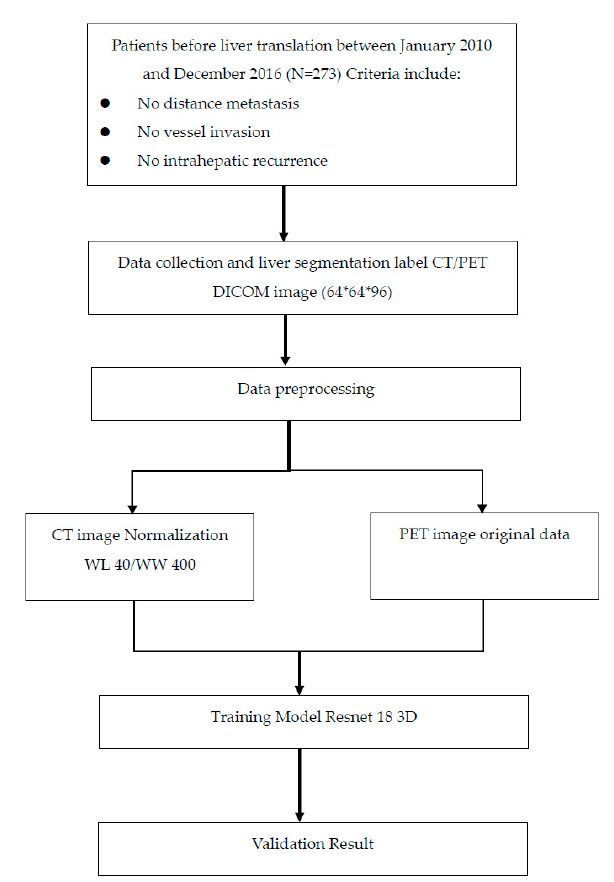
Figure A1. Flowchart.